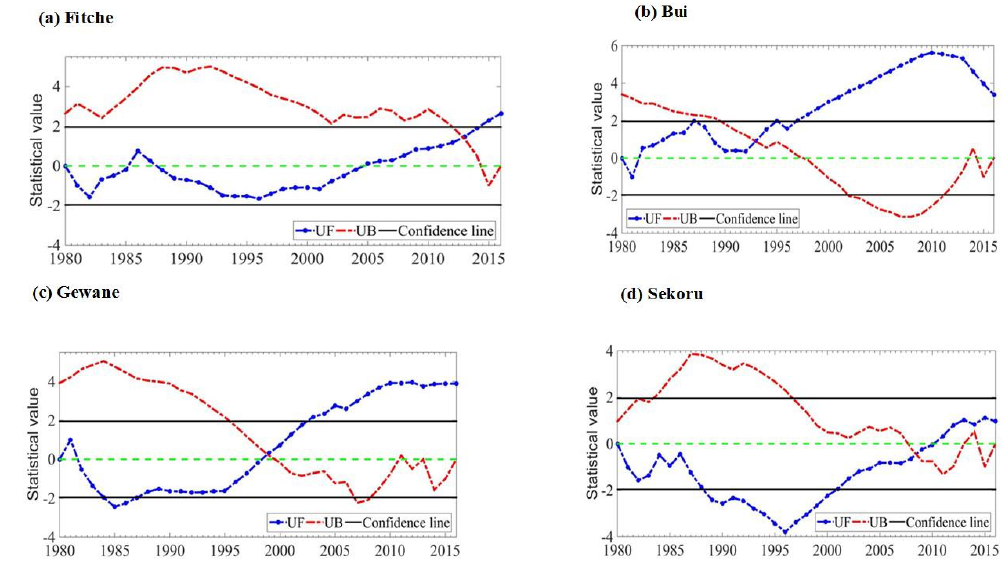
Figure 3. Trends of annual temperature across stations (note: U B = −U F ). Table 5. Results of MK, ITAM, and Sen’s slope estimator tests for temperature. No.